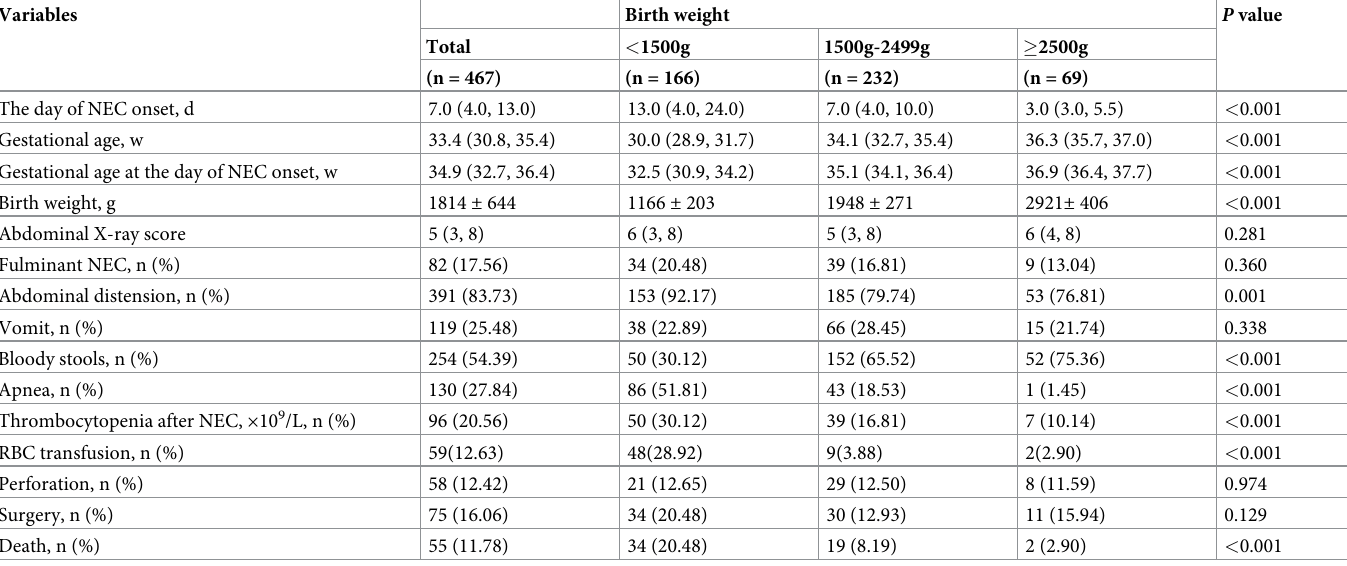
Table 1. Clinical manifestation of NEC in infants with different birth